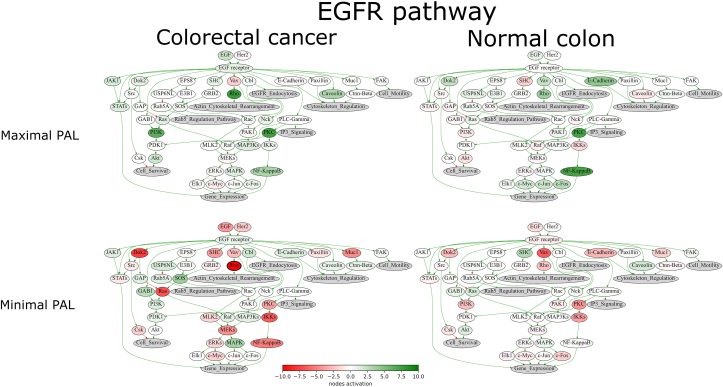
EGFR pathway (Qiagen Pathway Central) shown as an interacting network for samples with maximal (top) or minimal (bottom) PAL in colorectal cancer (left) vs normal colon (right). Green/red arrows indicate activation/inhibition interactions, respectively. The color depth of transcript nodes reflects the extent of node activation (logarithms of the expression fold change for each node, the reference is the geometric average between expression levels in all samples in the respective groups). Visualized using Oncobox software.